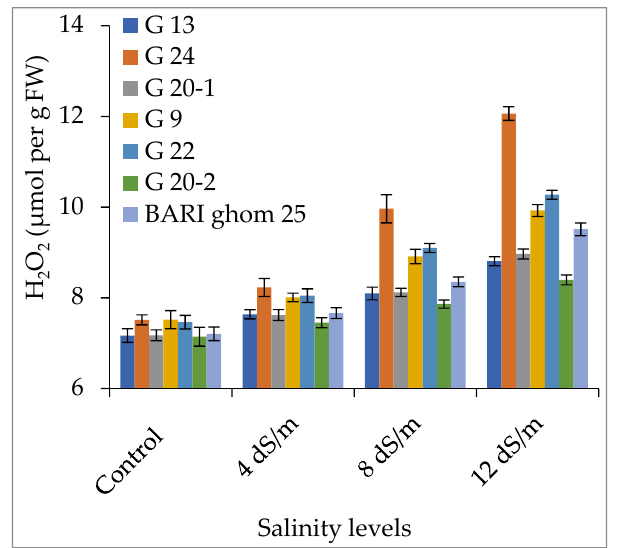
Figure 17. Hydrogen peroxide (H 2 O 2 ) accumulation in leaf of wheat genotypes under various salinity levels. The vertical bar indicates average data of five independent replicates ( n = 5). Error bars represent standard error.